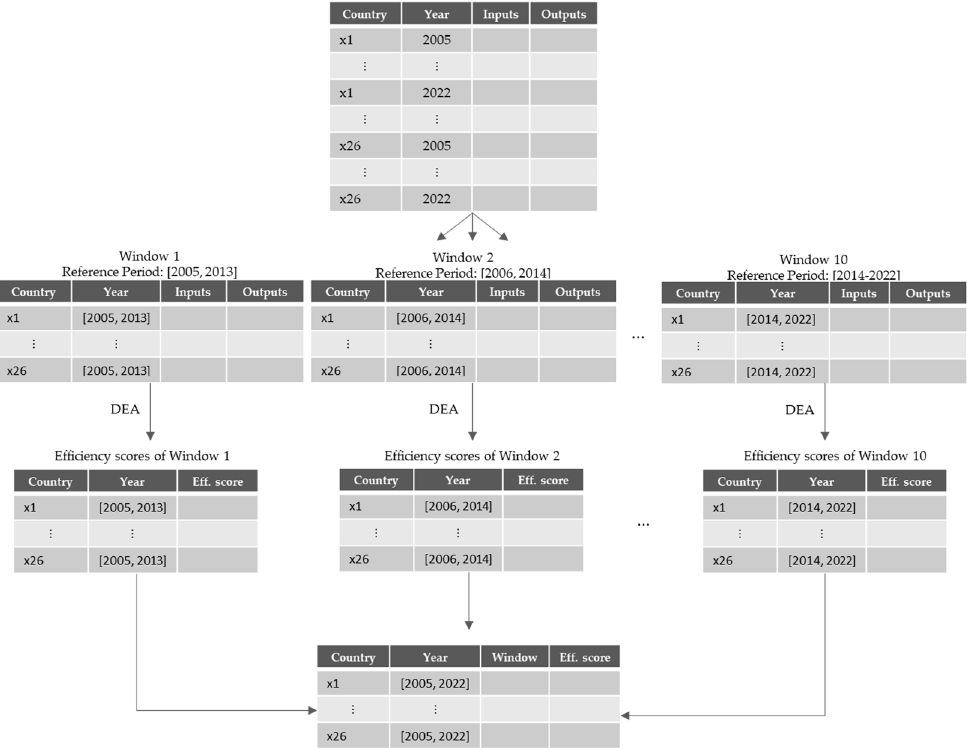
Figure 1. Step by step representation of the applied methodology. Table 3. Window DEA analysis representation for actual and projected